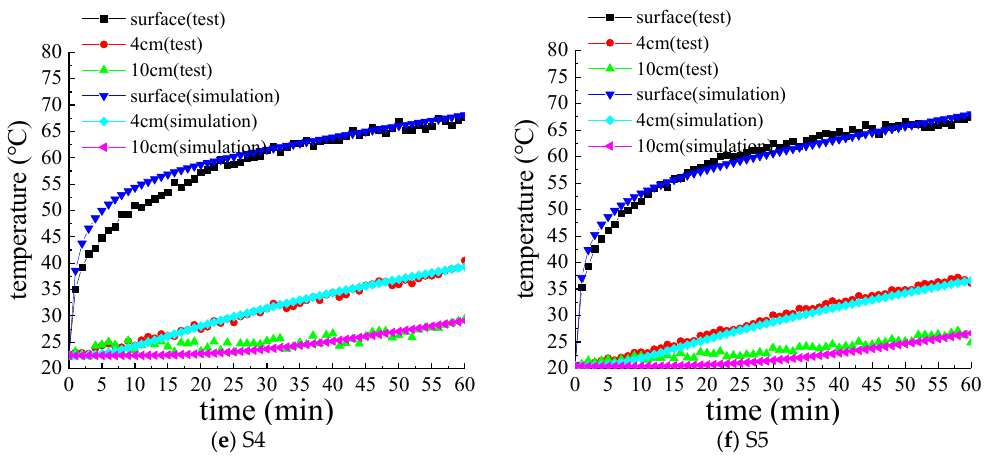
Figure 4. Temperature variation curves of each specimen.